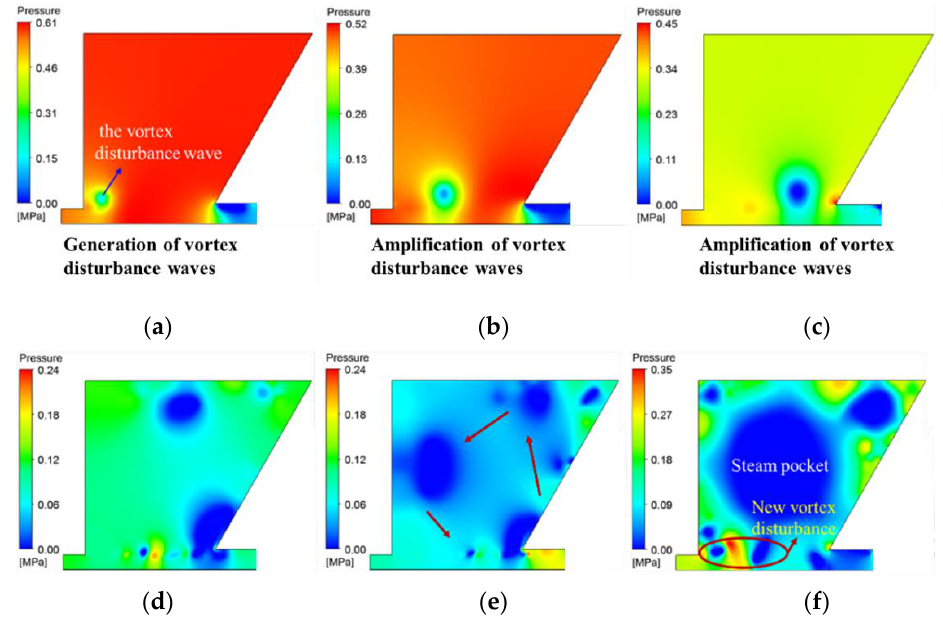
Figure 6. Pressure contours in the SOC at different times. ( a ) Generation of vortex disturbance waves ( b ) Amplification of vortex disturbance waves ( c ) Amplification of vortex disturbance waves ( d ) Interaction between wall and disturbance waves ( e ) Reflection of disturbance waves ( f ) Generation of new vortex disturbance waves and steam pocket.